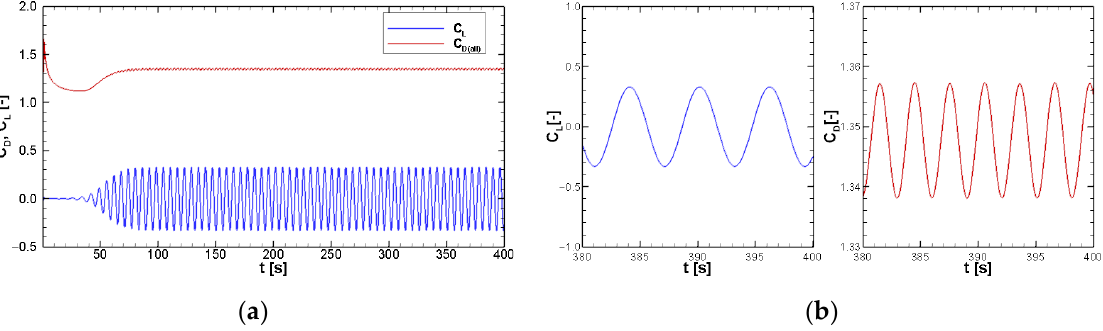
Figure 14. Lift and drag coefficients for the ( a ) entire and ( b ) partial simulation times ( Re = 100).